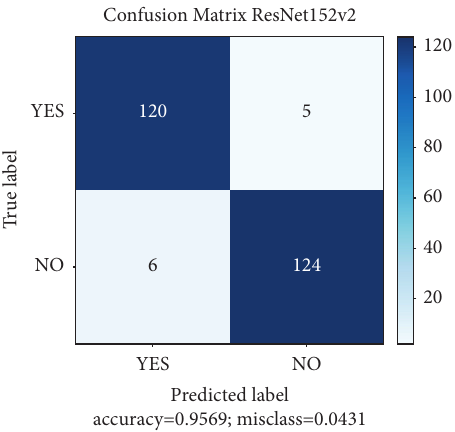
Figure 14: ResNet152V2 network architecture accuracy based on F1-score.